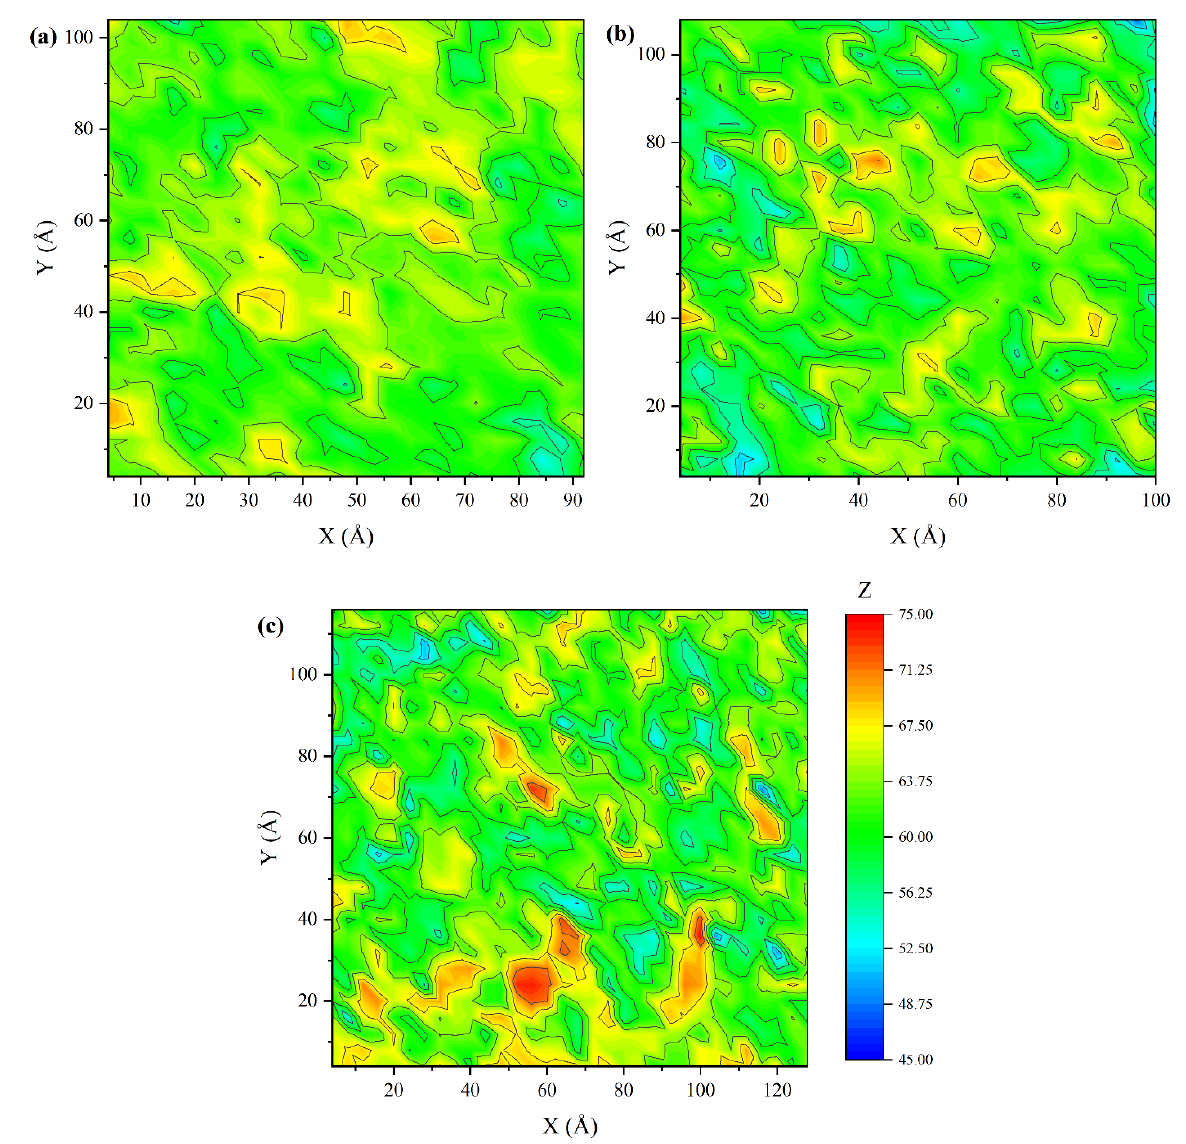
Figure 4. Contour maps of three antifouling membrane surfaces. ( a ) T4-DM, ( b ) T4-SP, ( c ) T4-SB. To quantify the surface roughness of three antifouling membranes, the root mean Table 1. Root-mean-square roughness of three antifouling membranes. square roughness R was introduced